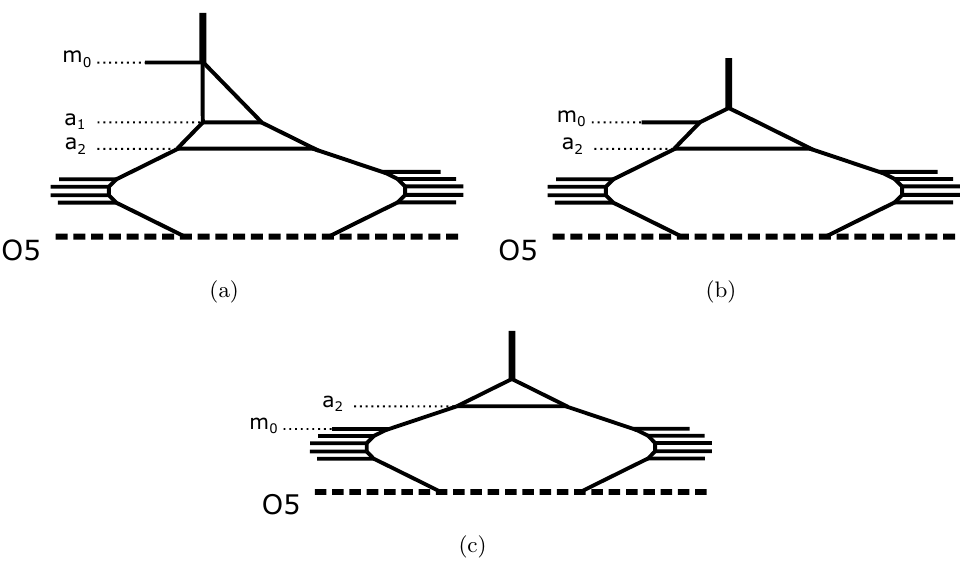
Figure 9 . (a). The 5-brane web diagram for the Sp(2) gauge theory with nine (cid:13)avors. (b). Lowering the left top D5-brane in (cid:12)gure 9(a) until the its height is lower than the that of the top color brane. (c). The diagram after performing a (cid:13)op transition with respect to a line of the length m 0 a 2 in (cid:12)gure 9(b). (cid:0) length m 0 a 2 , which yields the diagram in (cid:12)gure 9(c). Therefore the prepotential on (cid:0)